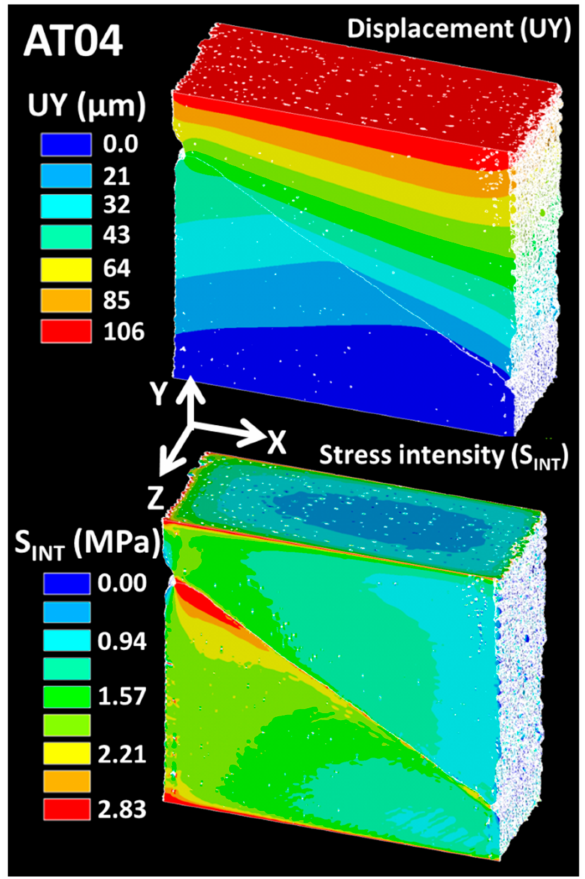
Figure 16. Displacement component UY and stress intensity fields issued from 3D image-based finite element computation for